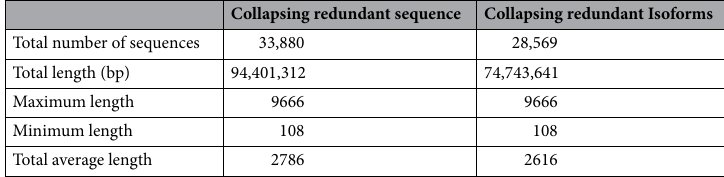
Table 2. Summary of high-quality non-redundant Iso-seq data for faba bean.